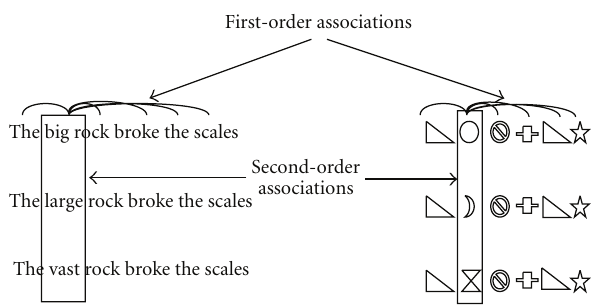
Figure 1: On the right, there are three synonymous sentences that describe the same information chunk. On the left, three di ff erent synonymous episodes are made of various shapes. The relationship between synonyms in both groups is illustrated by vertical bands. The word “big”, for example, does not directly associate with “large” but indirectly by appearing in groups with similar words. As illustrated on the left, there is no reason that the higher-order synonymic information which underlies words need be confined to linguistics since first- and higher-order associations can also exist between entities (in this case, shapes) that get grouped into